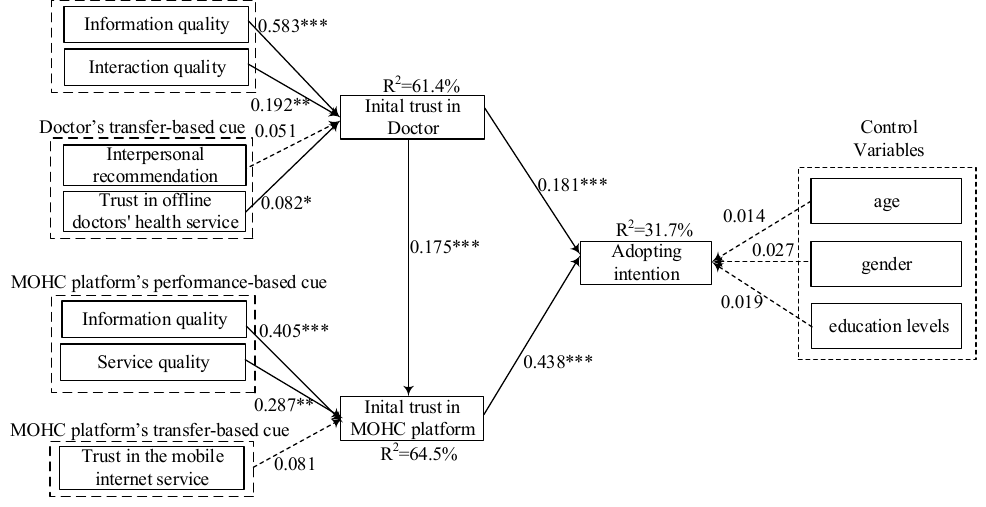
Figure 2. Structural Model. (Note: * p < 0.05; ** p < 0.01; *** p <